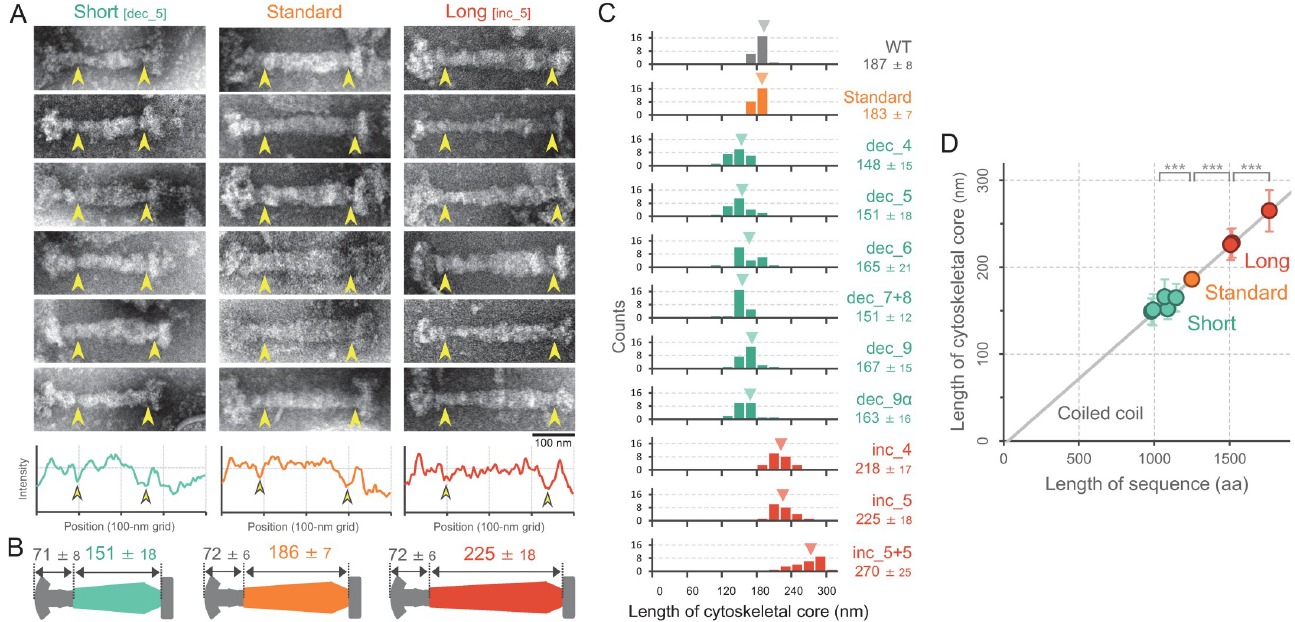
Fig 4. Cytoskeletal core of the size-modified HMW2-derivative mutants. (A) Top : EM images. Cells were treated with 1% Triton X-100, and the remaining structure was observed under negative-staining EM. The distance between the structural boundary indicated by the yellow arrowheads was measured as the length of the cytoskeletal core. Bottom : The intensity profiles of cytoskeletal structure along the longer axis were measured, and the average from 6 image were shown. The structural boundaries at the distal and the proximal parts were marked by yellow arrowheads. (B) Schematics of the isolated cytoskeletal cores. (C) Length distribution of the cytoskeletal core. The average and SD of 24 structures were presented, and the average was marked by a triangle in each panel. (D) Relationship between the cytoskeletal core length and the total amino acid numbers of coiled-coil domains in HMW2 derivatives. The average and SD in panel C were plotted. The linear fit was shown as a gray line. All data were analyzed from images of the bold -type structure. Statistical analysis followed by t -test are shown; ��� p 0.001.